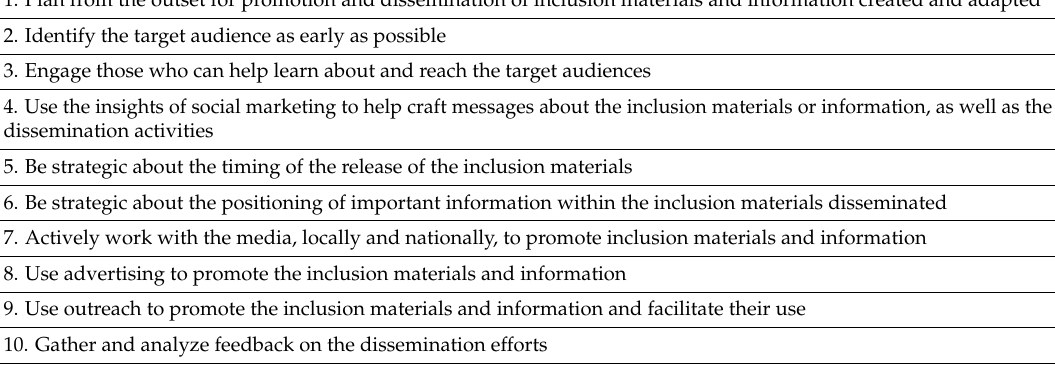
Table 1. The Agency for Healthcare Research and Quality’s 10 Dissemination Strategies [32]